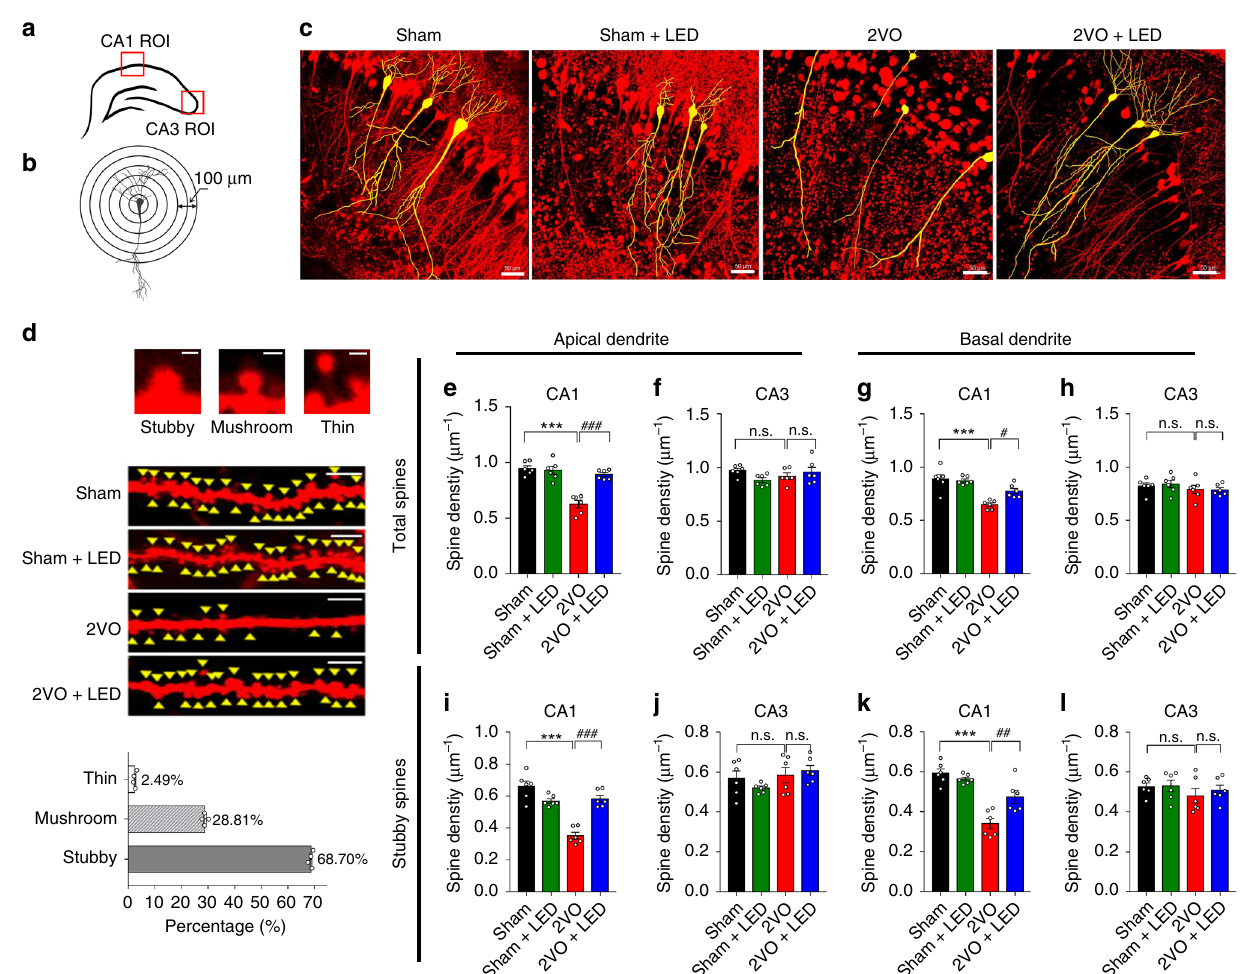
Fig. 6 Structural plasticity of CA1 and CA3 neurons in response to 40 Hz light treatment. a A diagram of CA1 and CA3 areas where two-photon images were taken and shown in panel c . b Camera lucida of a CA1 pyramidal neuron for Sholl analysis. Scale bar = 100 μ m. c Representative pyramidal neurons in CA1 of four groups (yellow colored lines) were put together using a z-stack of over 500 optical sections (6 repeats from n = 3 mice in each group). Scale bars = 50 μ m. d Representative two-photon images of stubby, mushroom, and thin-formed dendritic spines (top panels) of the apical dendrites of Thy1- YFP mice of Sham, Sham + LED, 2VO, and 2VO + LED groups at 3 d post-surgery (6 repeats from n = 4 mice). Scale bars = 5 μ m. The percentage of stubby, mushroom and thin shaped boutons were averaged and shown in the lower panel of d ( n = 4 mice). e – l Quanti fi cations of the number of dendritic spines per unit length of the CA1 and CA3 apical and basal dendrites, respectively, at 3 d post-surgery ( n = 6 slices/3 mice in each group). Data represent the mean ± SEM. Error bars indicate SEM. *indicates differences between the Sham group and 2VO group; # indicates differences between the 2VO group and 2VO + LED group. # P < 0.05, ## P < 0.01, ***, ### P < 0.001. The test used in e – l 2ANOVA with Tukey ’ s post hoc test. Source data are provided as a Source Data fi